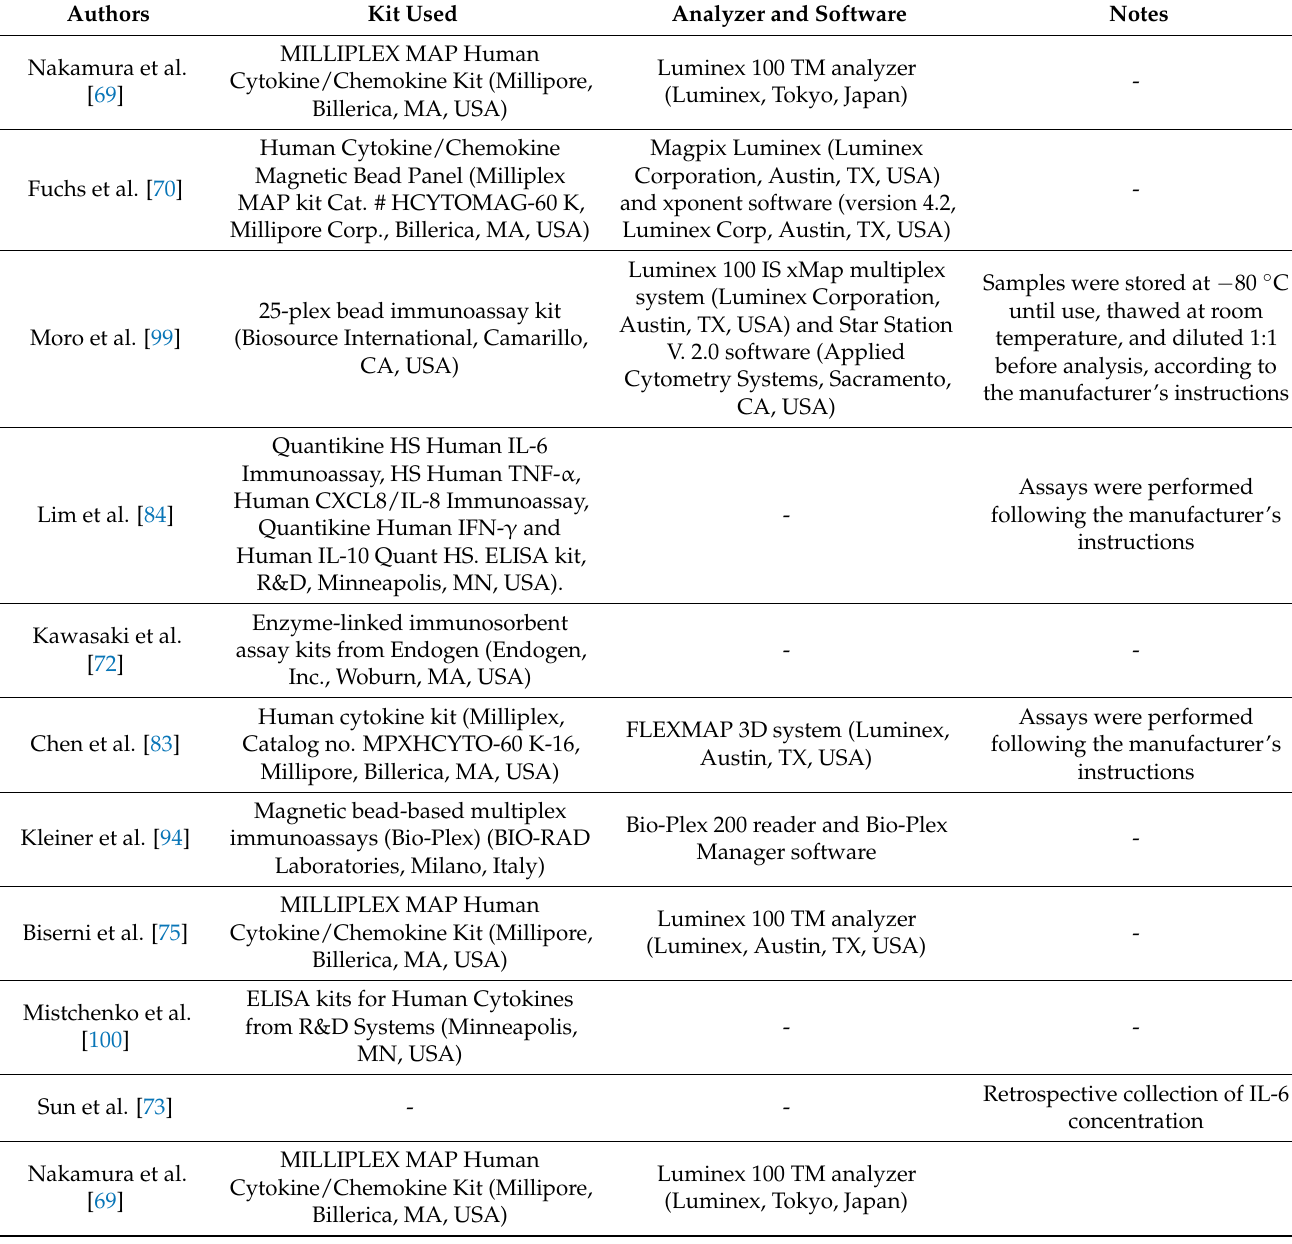
Table A1. Laboratory methods used for the assessment of inflammatory